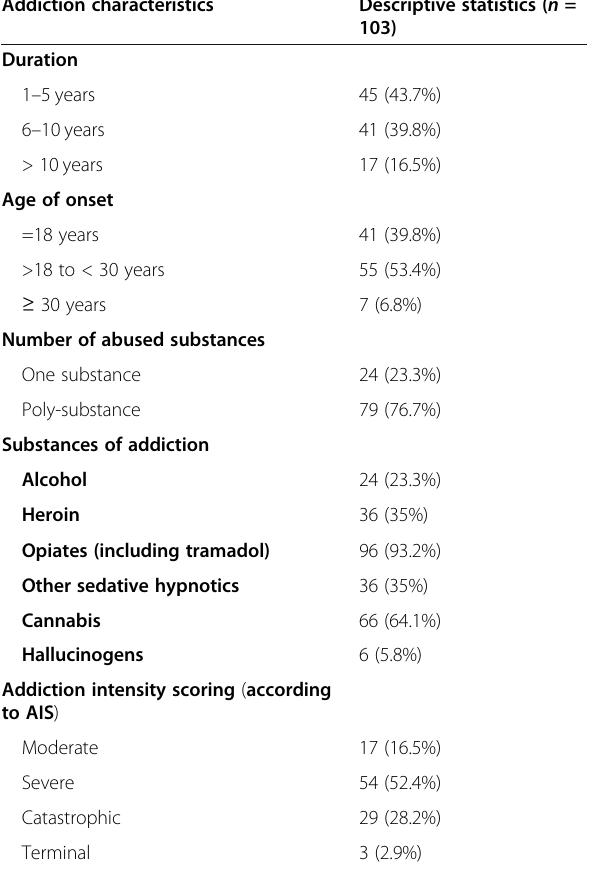
Table 2 Descriptive data of addiction